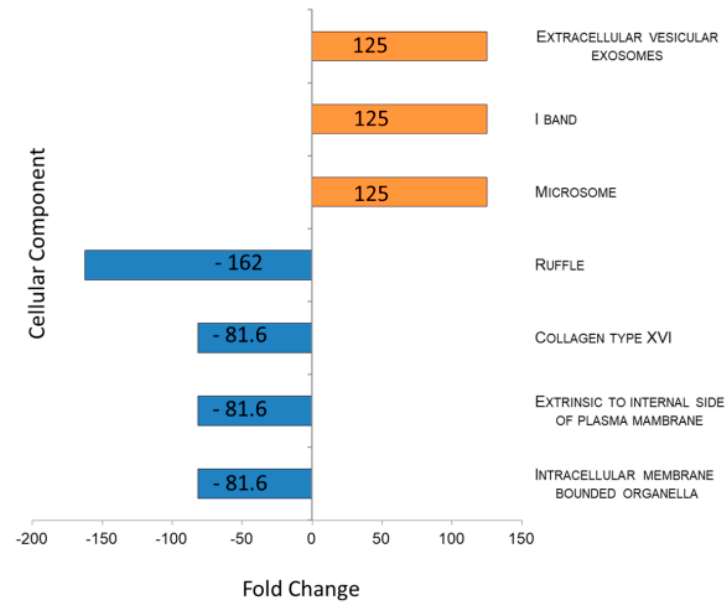
Figure 3. Histogram representing enrichment analysis performed on Cellular Component using FunRich database. Enriched and Depleted Cellular component in tears of POAG patients are reported in blue and in orange, respectively. Gene Ontology code for each CC reported in figure: EV